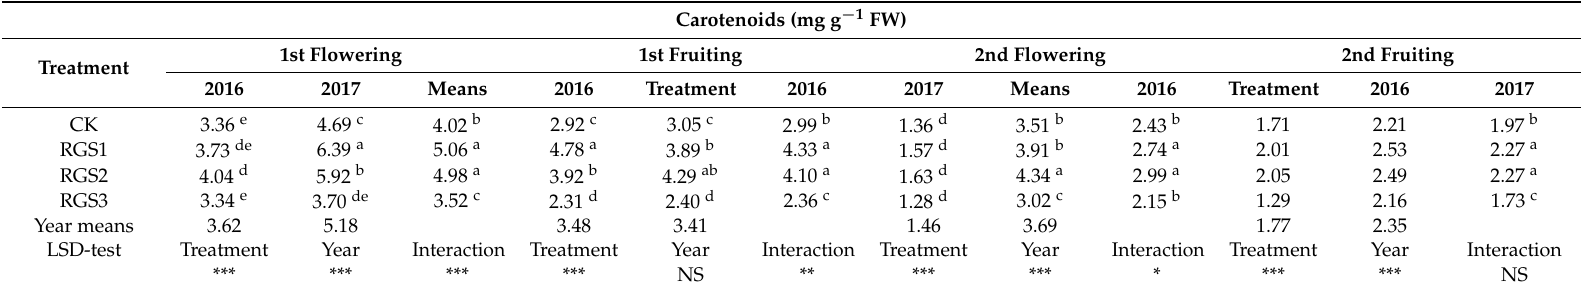
Different letters indicate significant differences between means within columns at p < 0.05 (ANOVA and LSD). * p < 0.05, ** p < 0.01, *** p < 0.001. NS: Non-significant. Table 4. Effect of amendment with raw garlic stalk on